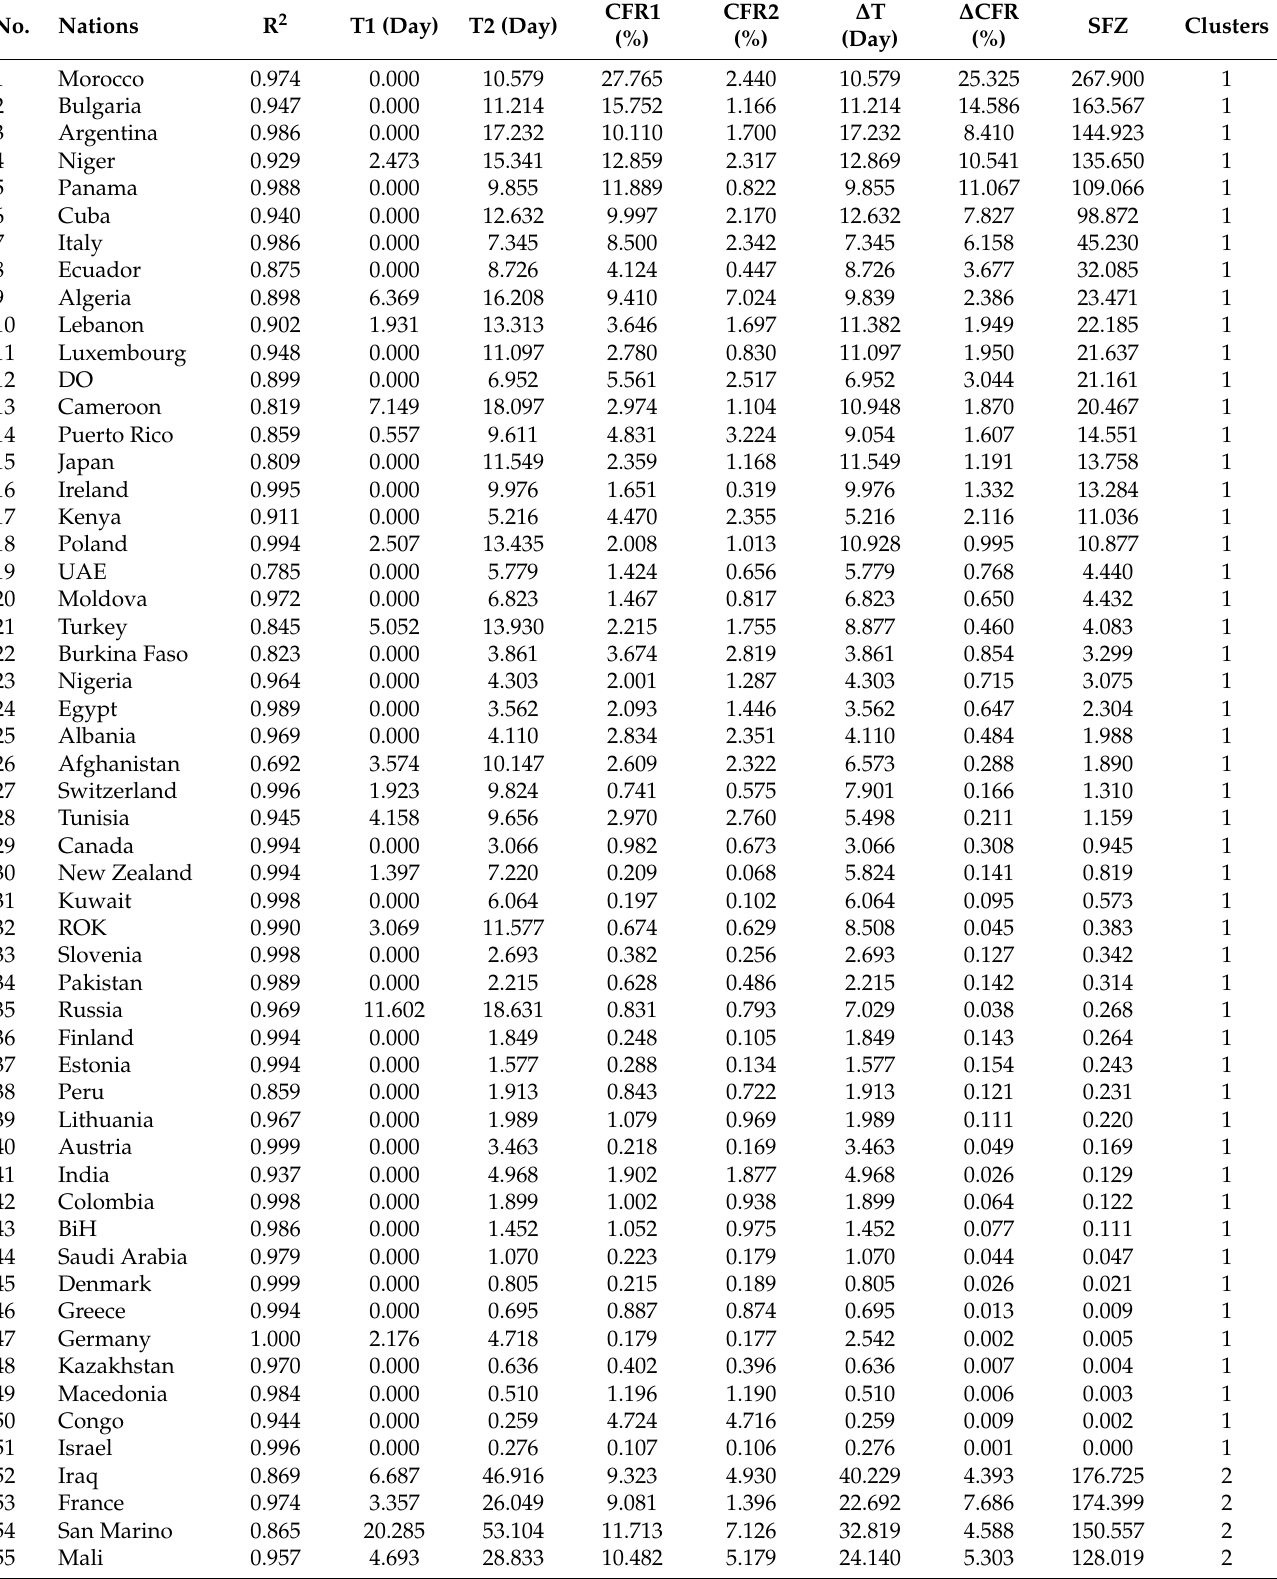
Table 1. Characteristic parameters of 3DMA-CFR curves in initial COVID-19 epidemics for 71 nations and